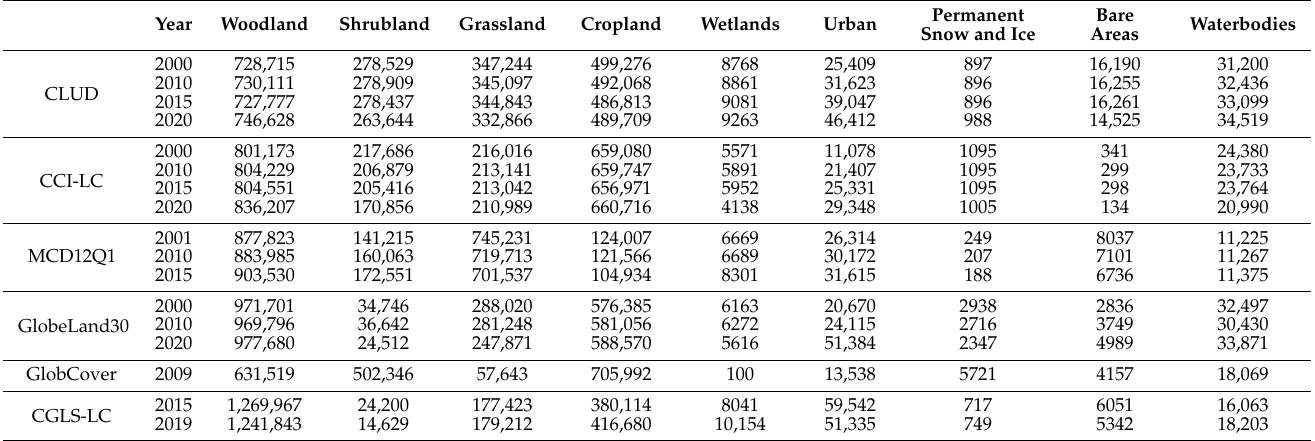
Table A1. Area of each class type in each land cover dataset (unit: km 2 ).